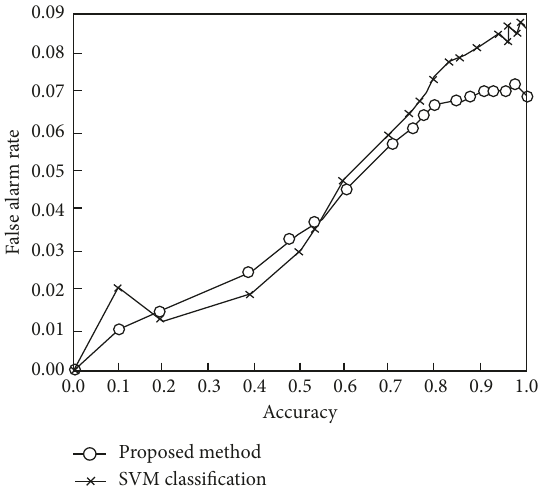
Figure 12: Abnormal detection of the ROC